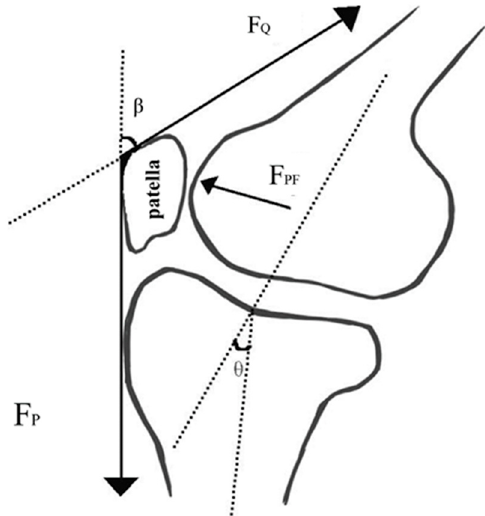
Figure 3. Free-body diagram of the patellofemoral joint. Notes: F Q refers to the quadriceps muscle strength, F PF denotes the patellofemoral contact force, F P represents the patellar ligament tension line, β stands for the angle between the quadriceps muscle line and the patellar ligament tension line, and θ is the knee flexion